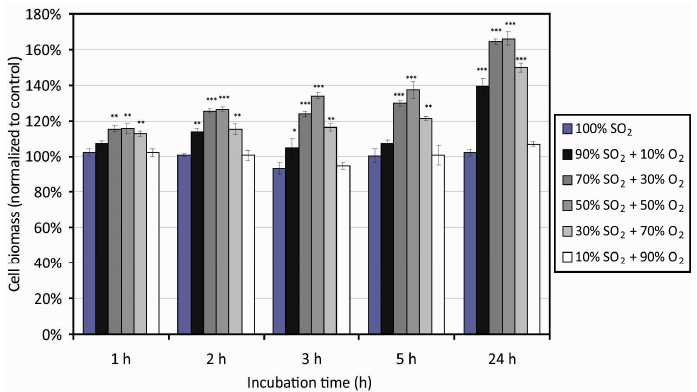
Figure 9. Results of the MTT assay for HUVEC cell proliferation on PET surfaces treated in various SO 2 + O 2 mixtures. Symbols * represent statistical significance ( ** represents statistical significance at p < 0.01 compared with the control. *** represents statistical significance at p < 0.001 compared with the control). Mean values (± SE) for the respective triplicates are given.